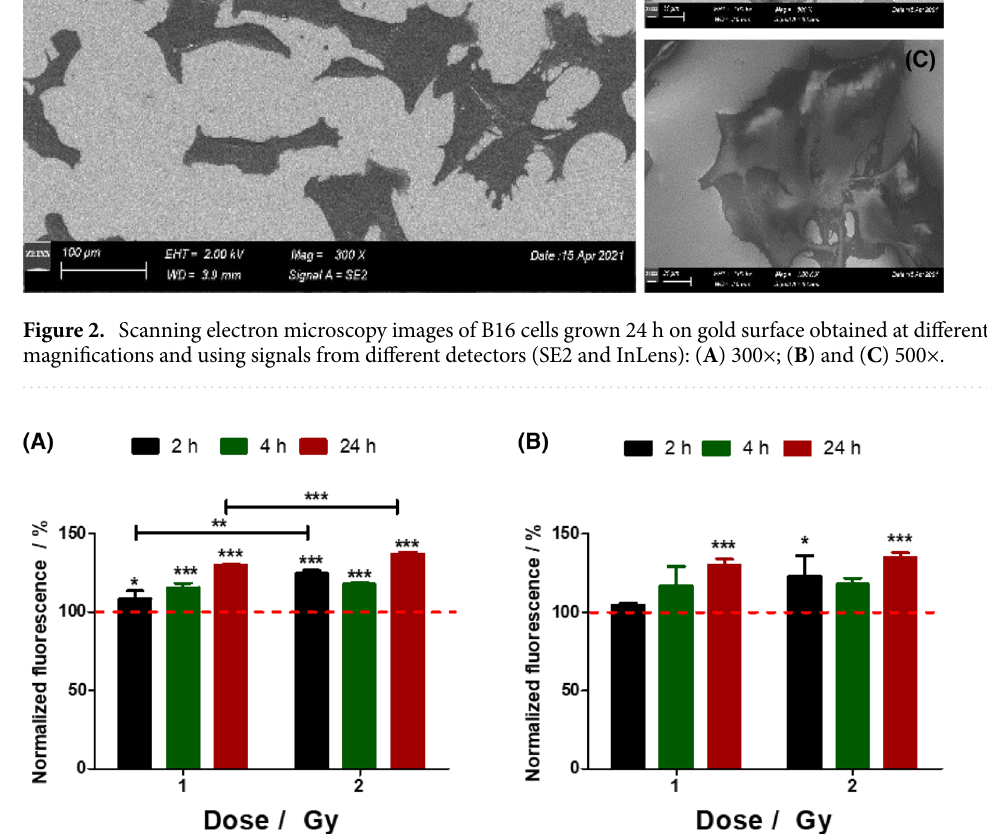
Figure 3. Normalized values to control cells (cells not irradiated) of ( A ) mitochondrial superoxide and ( B ) ROS recorded for B16 cells at 2, 4 and 24 h after proton irradiation at dose rate of 1 Gy/min. Data are reported as mean ± SD. *p < 0.05, **p ≤ 0.01 and ***p ≤